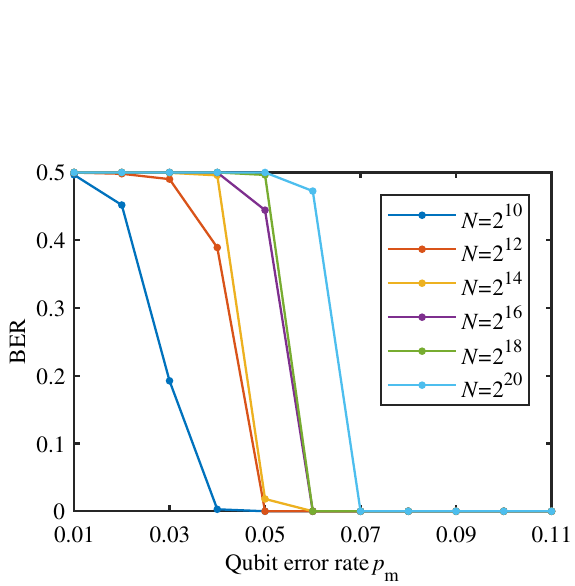
Figure 8. The decoding BER of Eve. The number of simulation tests is 1 × 10